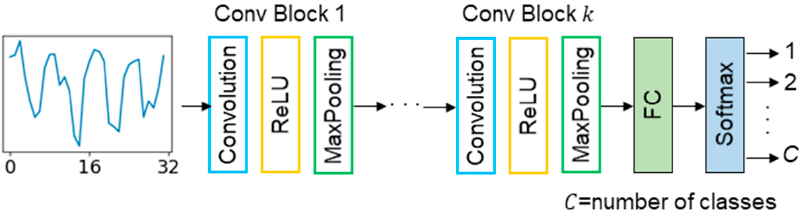
Figure 3. A 1D convolutional neural network (CNN)